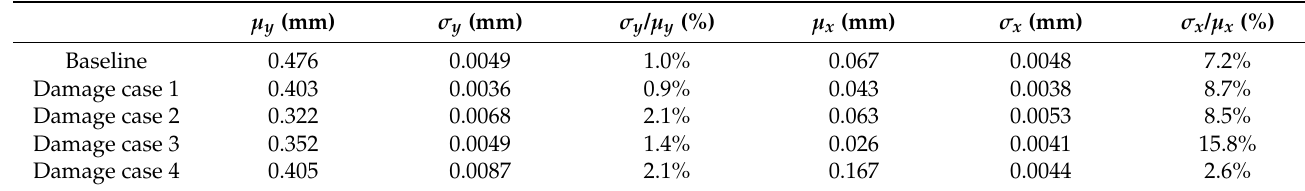
Figure 6. Vertical ( a ) and horizontal ( b ) displacements of the reference node for all of the runs. Table 2. Statistics of the reference node